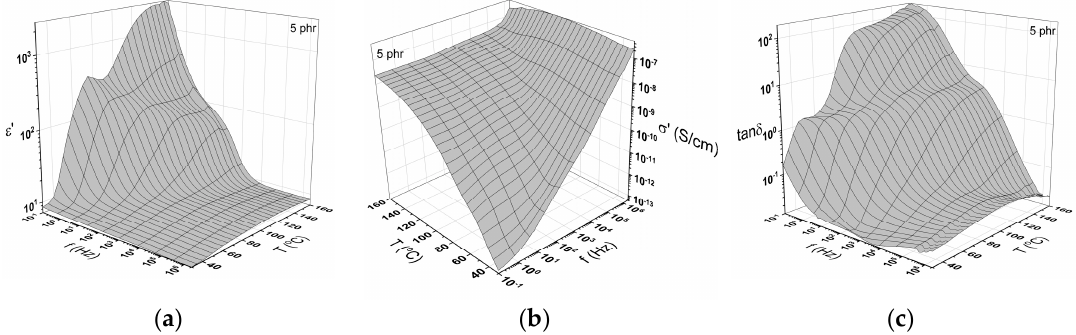
Figure 5. The variation of the: ( a ) Real part dielectric permittivity; ( b ) AC conductivity and ( c ) loss tangent as a function of frequency and temperature for the nanocomposite with 5 phr filler content.